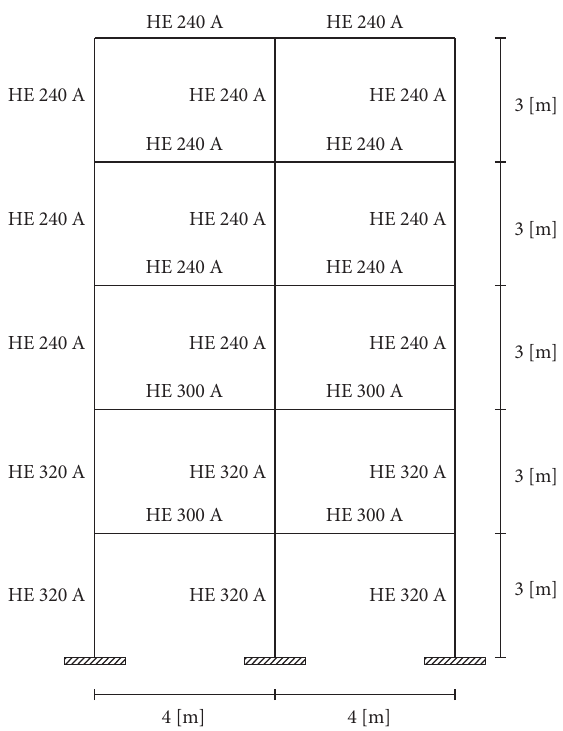
Figure 3: Frame with five floors and three columns.